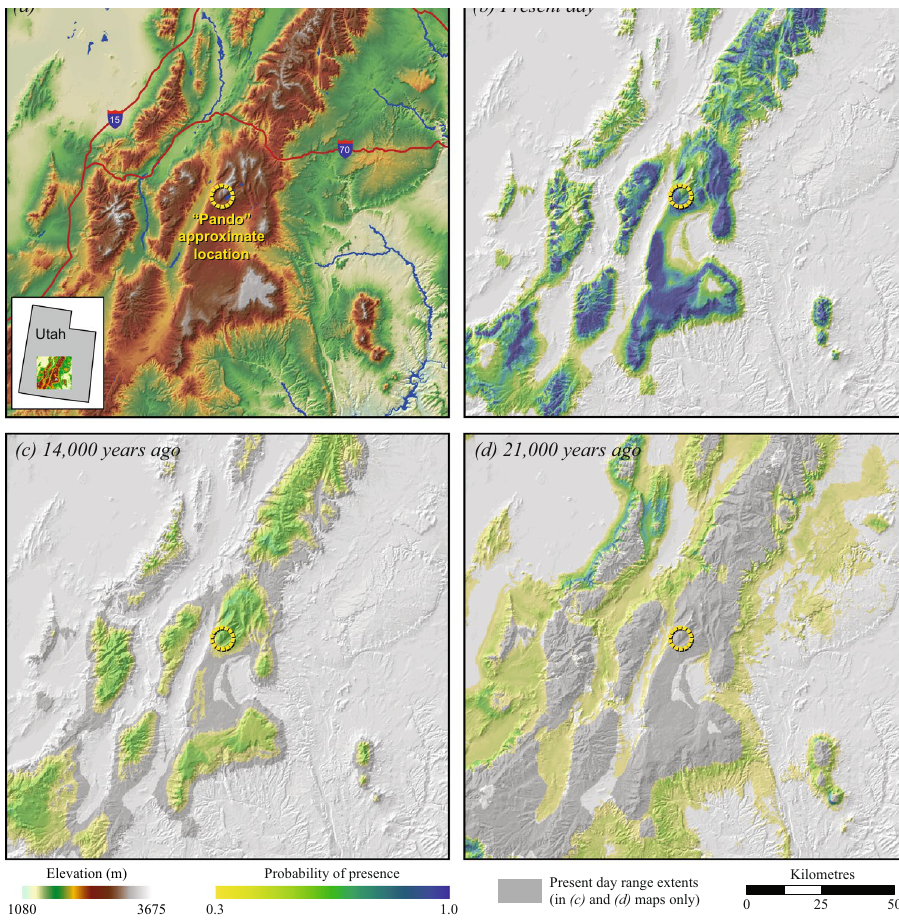
Figure 4. ( a ) Topographic map of south-central Utah highlighting the approximate location of the aspen clone “Pando”. Palaeoclimatic habitat projections for trembling aspen in south-central Utah ( b ) present day, ( c ) 14,000 years before present, ( d ) 21,000 years before present. The maps were created with ArcGIS v9.3